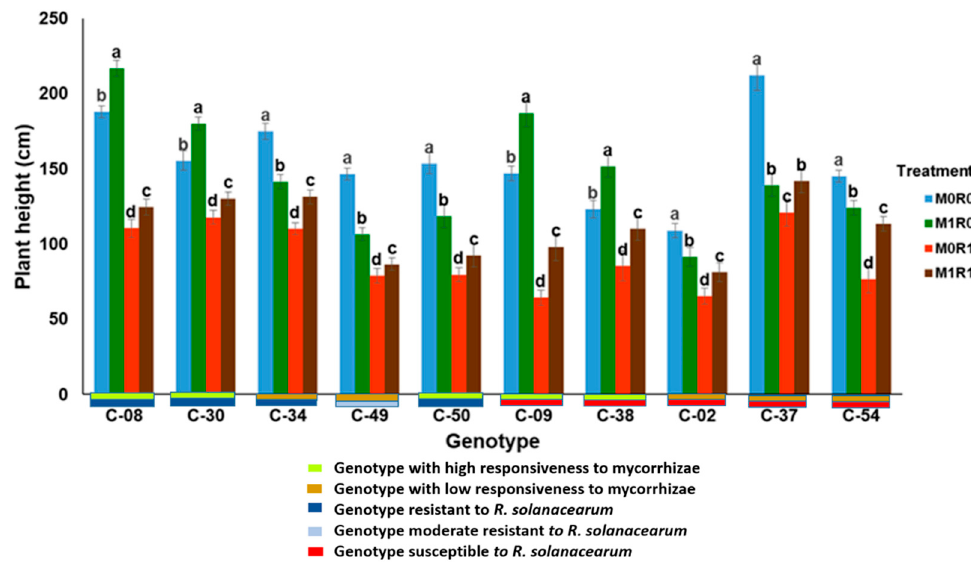
Figure 7. Plant height of ten genotypes tropical chili pepper as a phenotypic response to the treat- ments. Bars represent mean ± standard deviation. The same lowercase letters indicate no significant difference in mean values between treatments in each genotype according to the Scott-Knott test at a significance level of 0.95.